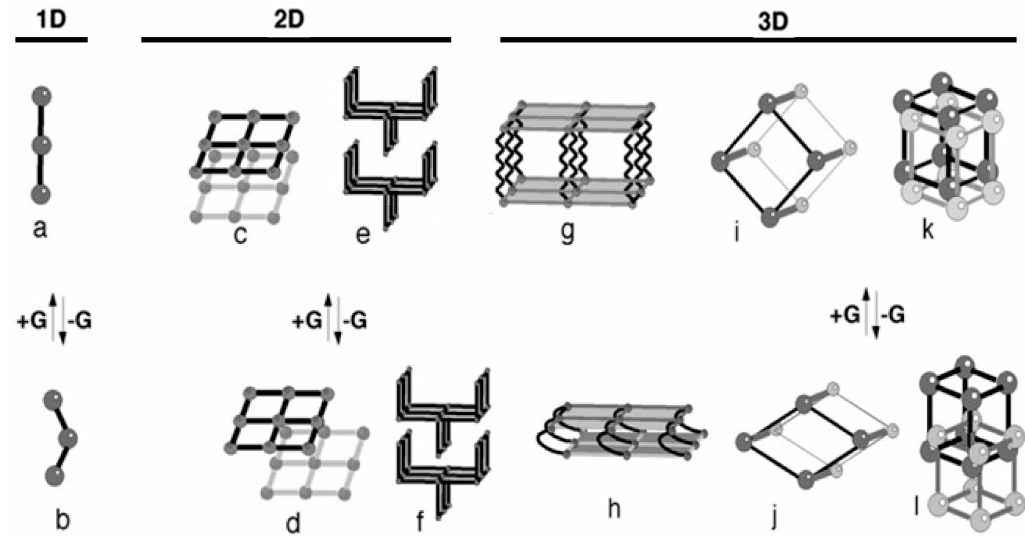
Figure 4. Illustration of dynamic behaviors of the metal-organic frameworks’ (MOFs) structure under the incorporation / removal of the guest molecule